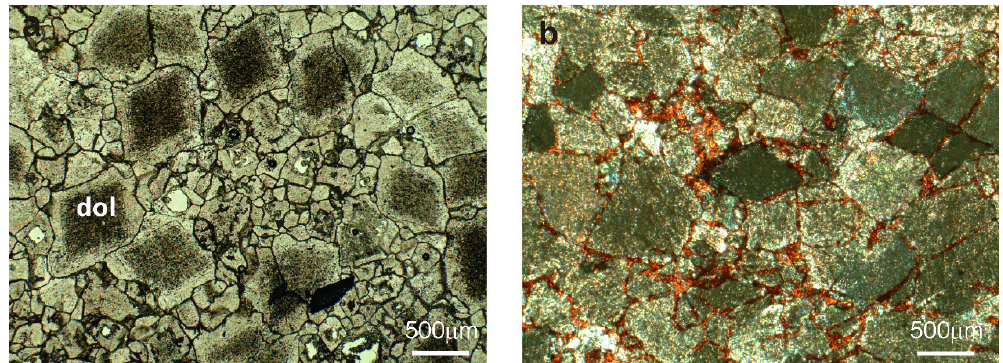
Figure 2. XRPD (x-ray powder diffraction) pattern of the dolostones used as aggregates to make the Camarasa concrete.